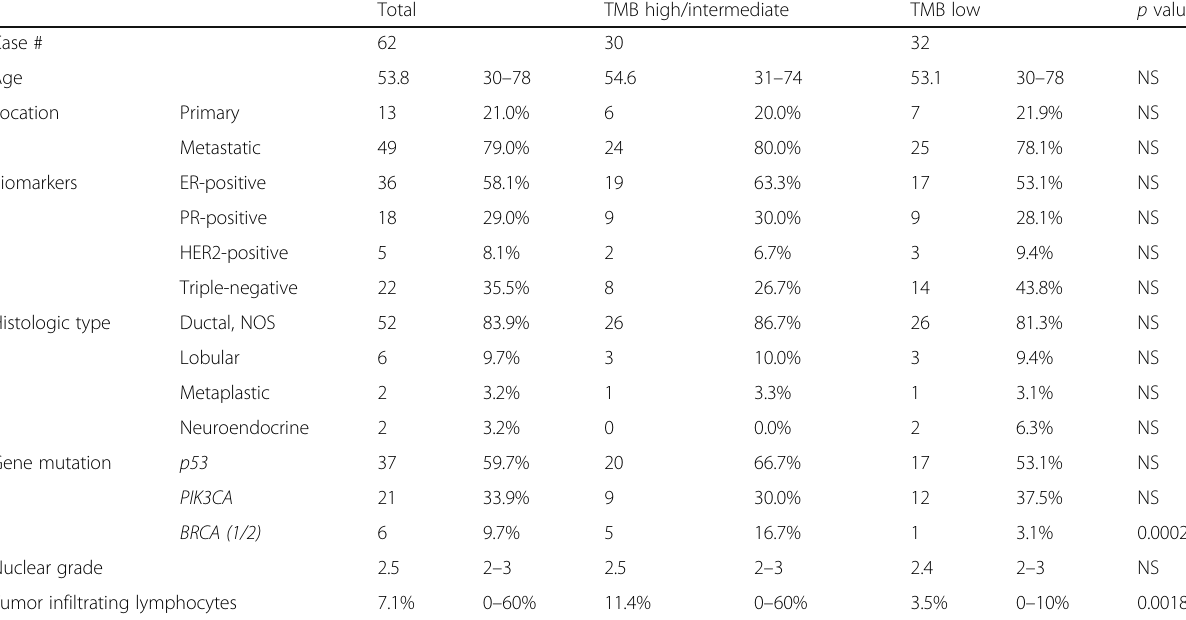
Table 2 Demographic characteristics and tumor mutation burdens of the study cohort ( n =